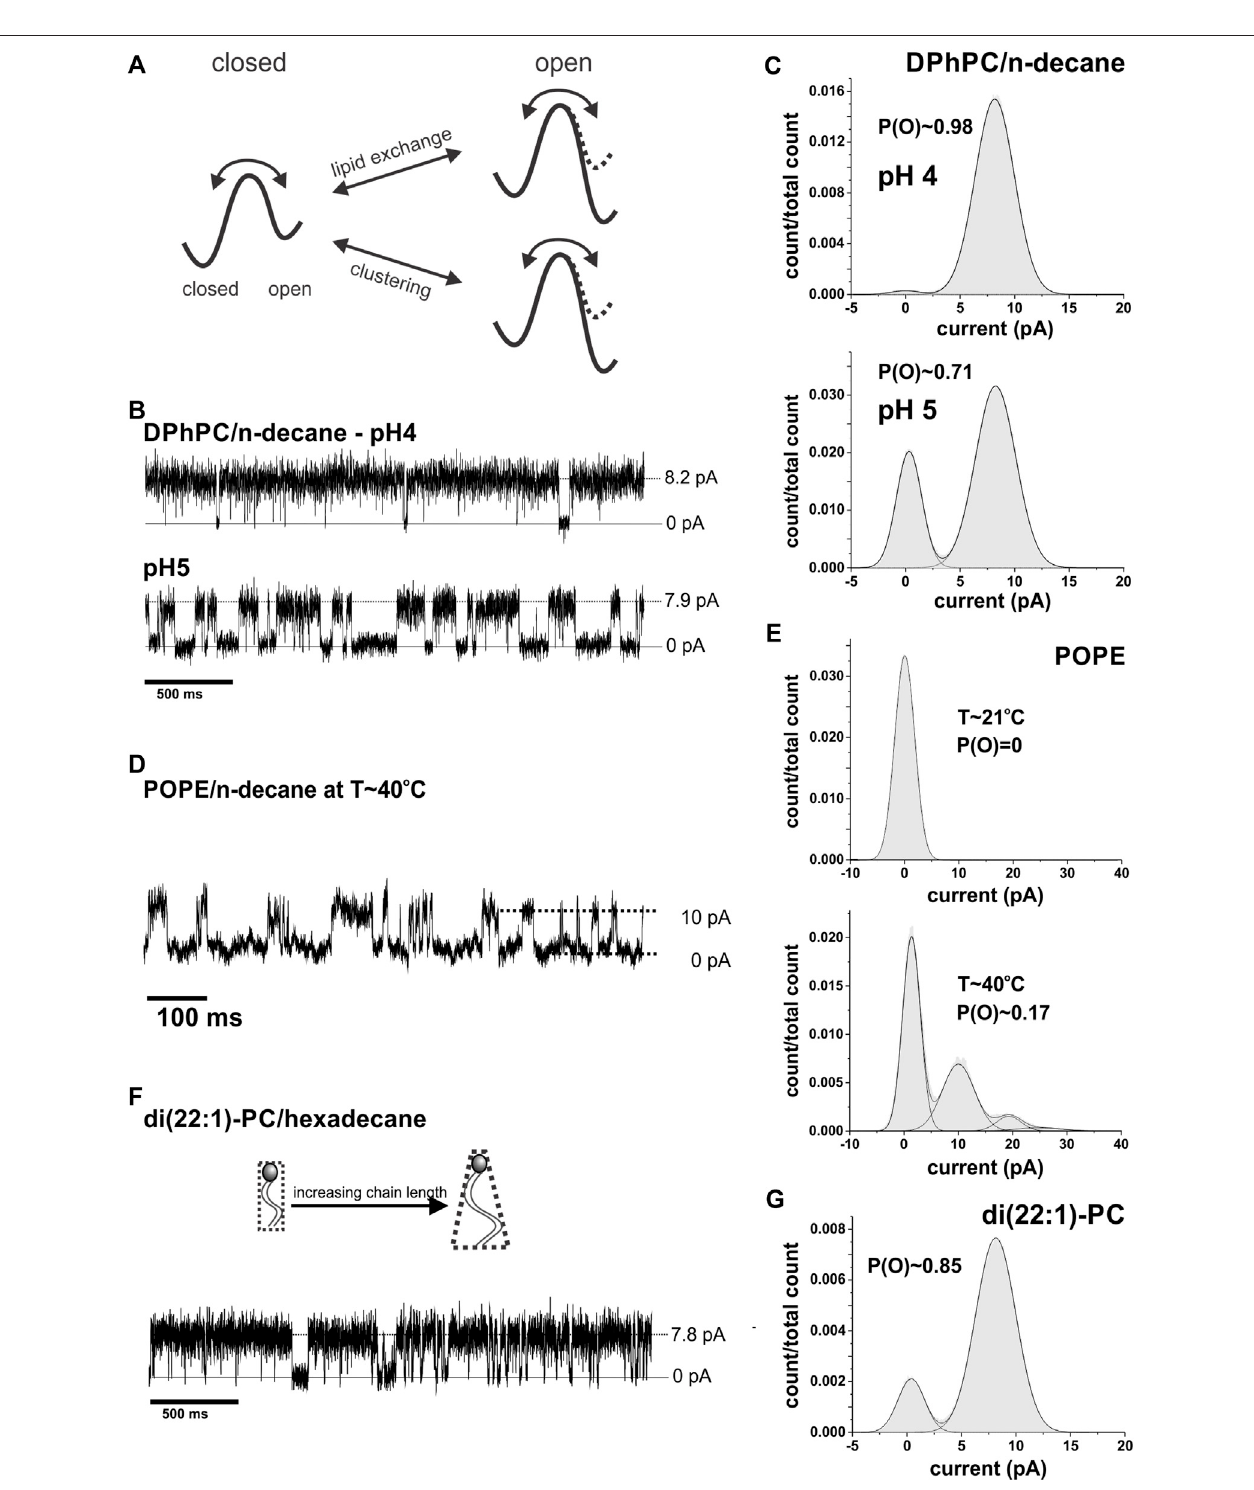
FIGURE 5 | Lipid dependence of single channel activity. (A) , Effect of lipid composition and clustering on the energy barrier for KcsA opening. While in a DOPC: DOPG mixture KcsAisactive, i.e., thefreeenergy isminimal intheopen state, theybecomeinactive inpureDOPC andthefreeenergyisminimal intheclosed state. The opening is thus limited by the lipid composition. This limitation is overcome by clustering; clustered channel again have minimal energy for the (cooperative) open state. (B) , Representative current traces of single channel activity of KcsA in pure DPhPC bilayers at pH 4 & 5 (N > 25). (C) , Amplitude histograms of traces shown in (B) . Theopenprobabilitywasfoundtobecloseto1 atpH4. (D) ,AnextractofacurrentrecordingofKcsAinpurePOPE/decaneathightemperature(T~40 ° C)isshown.The